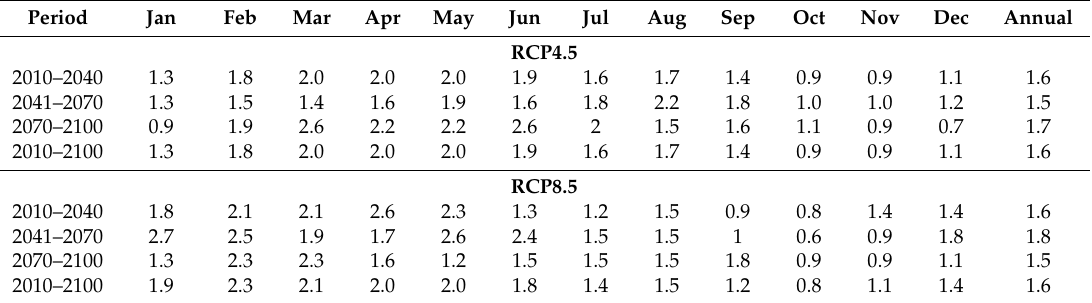
Table 6. Monthly average precipitation variation (mm) under near (2010–2040), middle (2041–2070) and future (2070–2100) climate change